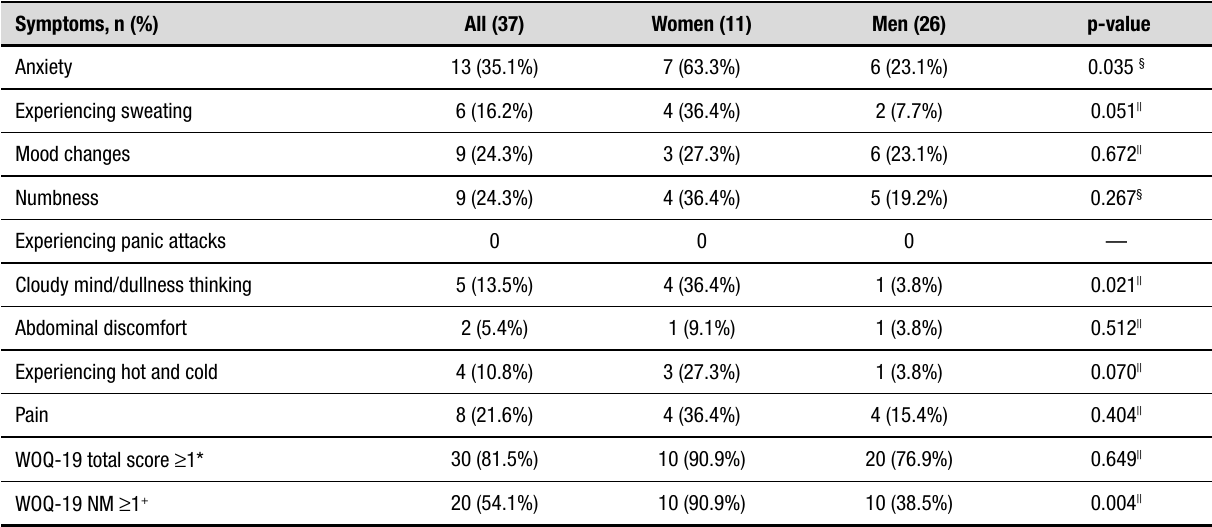
Table 2. Frequency of non-motor symptoms fluctuations according to the Wearing Off Questionnaire. Symptoms, n (%)